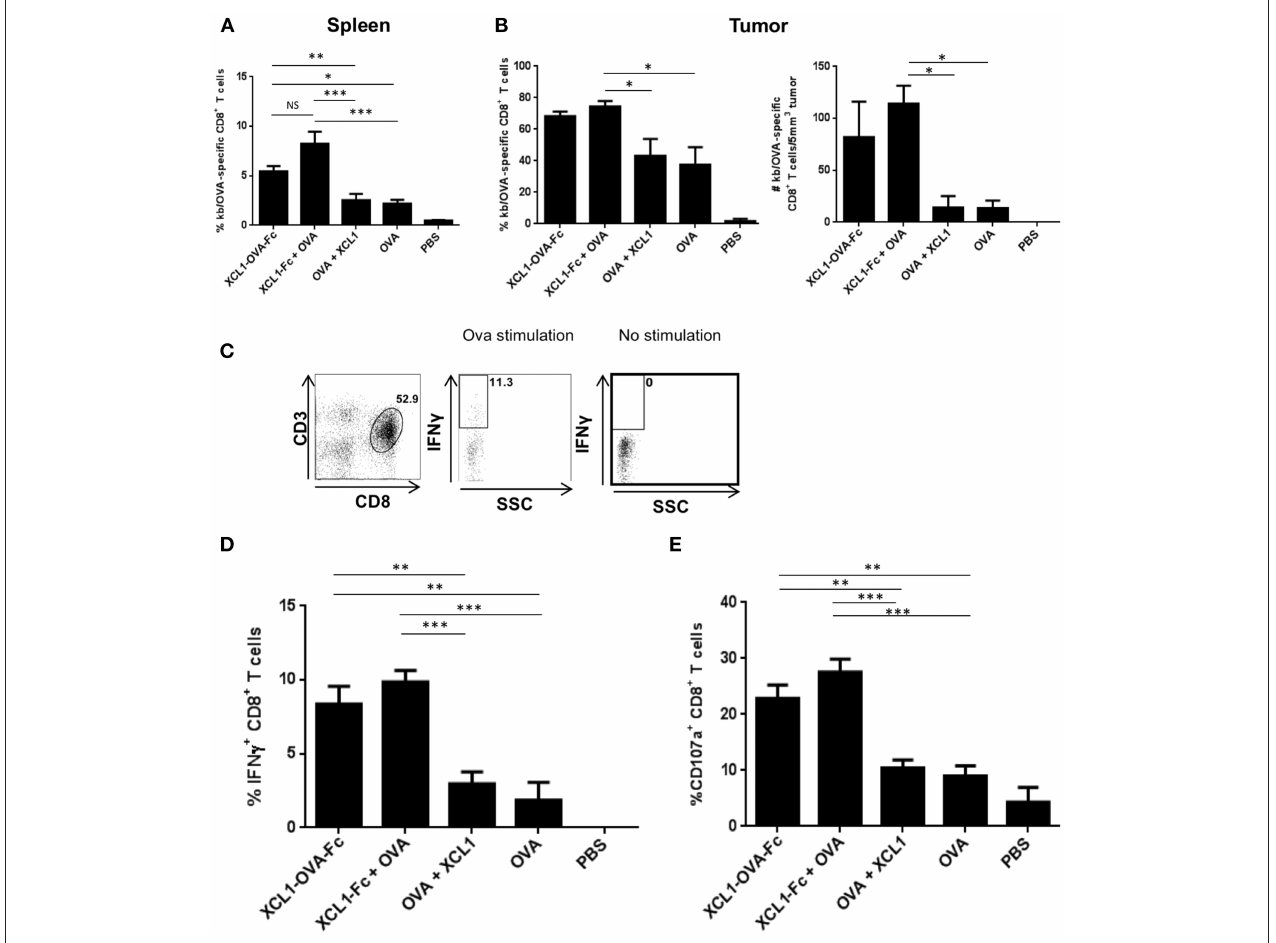
FIGURE 4 | Ex vivo function of TILs following Xcl1-fusion proteins vaccination. (A) Frequencies of OVA-specific CD8 + T cells in the spleens harvested 10 days post vaccination of mice challenged with B16.OVA on day 0, adoptively transferred with OT-I cells on day 7 and vaccinated on day 8. Data is shown as mean ± SEM ( n = 5 mice/group). Results are representative of two independent experiments. (B) Frequencies of H-2Kb/OVA tetramer positive CD8 + T cells present in the B16.OVA tumors of vaccinated mice (left panel), and absolute number of SIINFEKL-specific CD8 + T cells per 5 mm 3 of tumor mass (right panel). Data is shown as mean ± SEM ( n = 5 mice/group). Results are representative of two independent experiments. (C) Representative plots depicting the IFN γ content of CD3 + CD8 + T cells isolated from B16.OVA tumors 10 days post-vaccination and restimulated with or without SIINFEKL peptide. (D) Frequencies of IFN γ + CD8 + T cells and (E) of CD107a + CD8 + T cells isolated from B16-OVA tumors. Data is shown as mean ± SEM ( n = 5 mice/group). Results are representative of two independent experiments. * p < 0.05, ** p < 0.01, *** p <